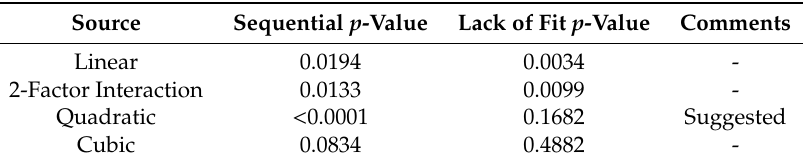
Table 5. Significance test for di ff erent pore area model options.